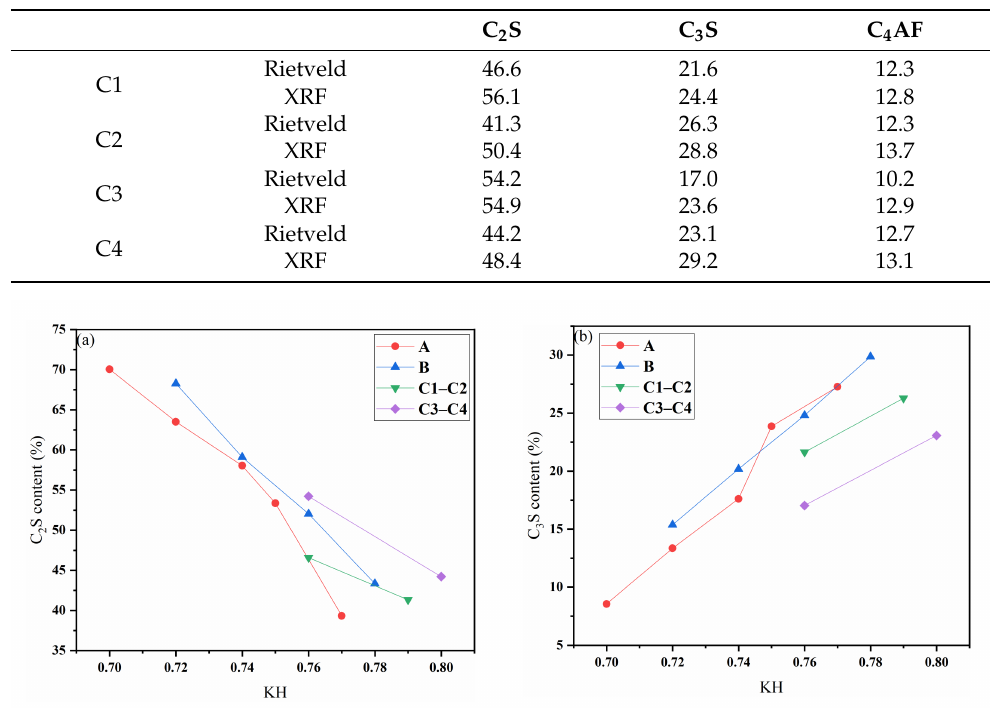
Figure 6. Diagram of phase variation with limestone saturation coefficient ( a ) C 2 S ( b ) C 3